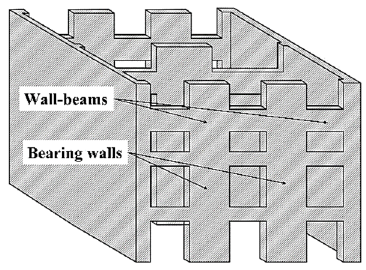
Figure 1. Reinforced concrete wall structural system.